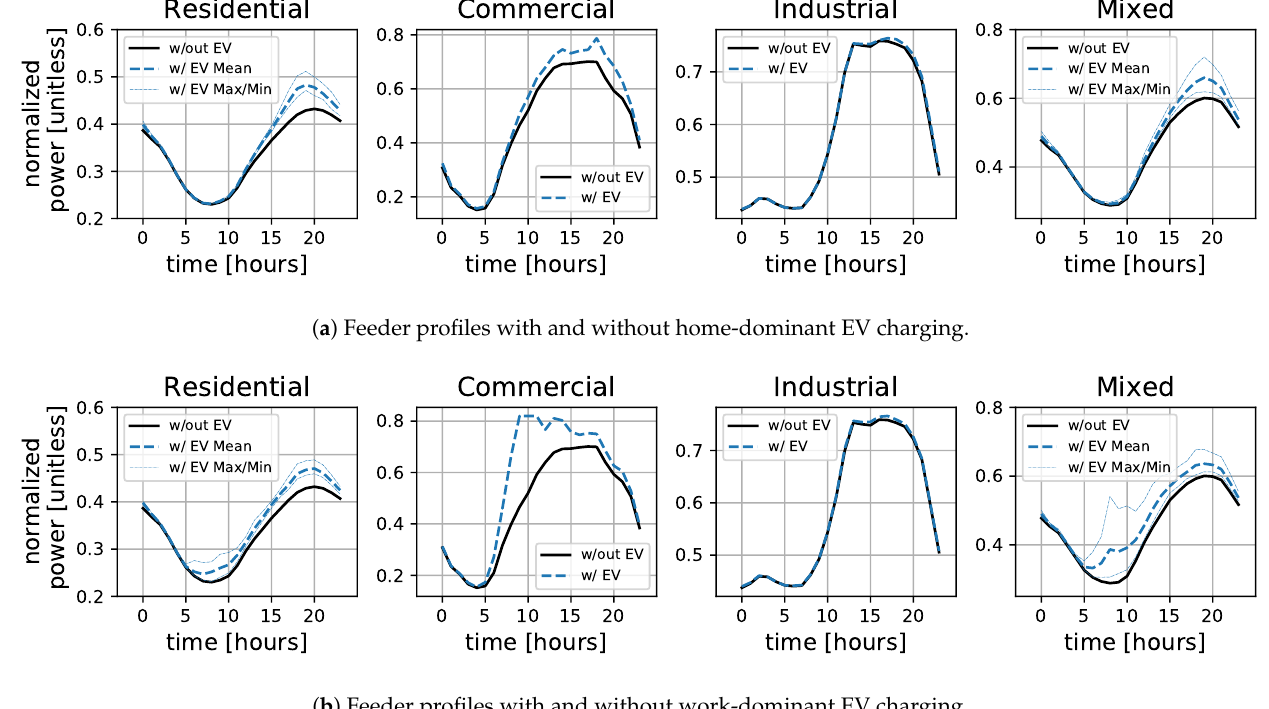
Figure 8. The impact of the Electric Vehicle (EV) charging profiles on the overall demand varied between the home- and work-dominant scenarios. The plots in subfigures ( a , b ) describe a potential change in the average feeder profile for the residential, commercial, industrial, and mixed systems. The figures highlight the average change for each group using the dashed line and the minimum/maximum potential change with the small dotted line. ( a ) The home-dominant case tended to increase each feeder type’s peak, which usually occurred between hours 17 and 20. ( b ) The work-dominant EV adoption strategy showed an increase in charging throughout the day for the residential feeders, a significant increase in the daytime charging for the commercial and mixed feeders, and no change in the industrial